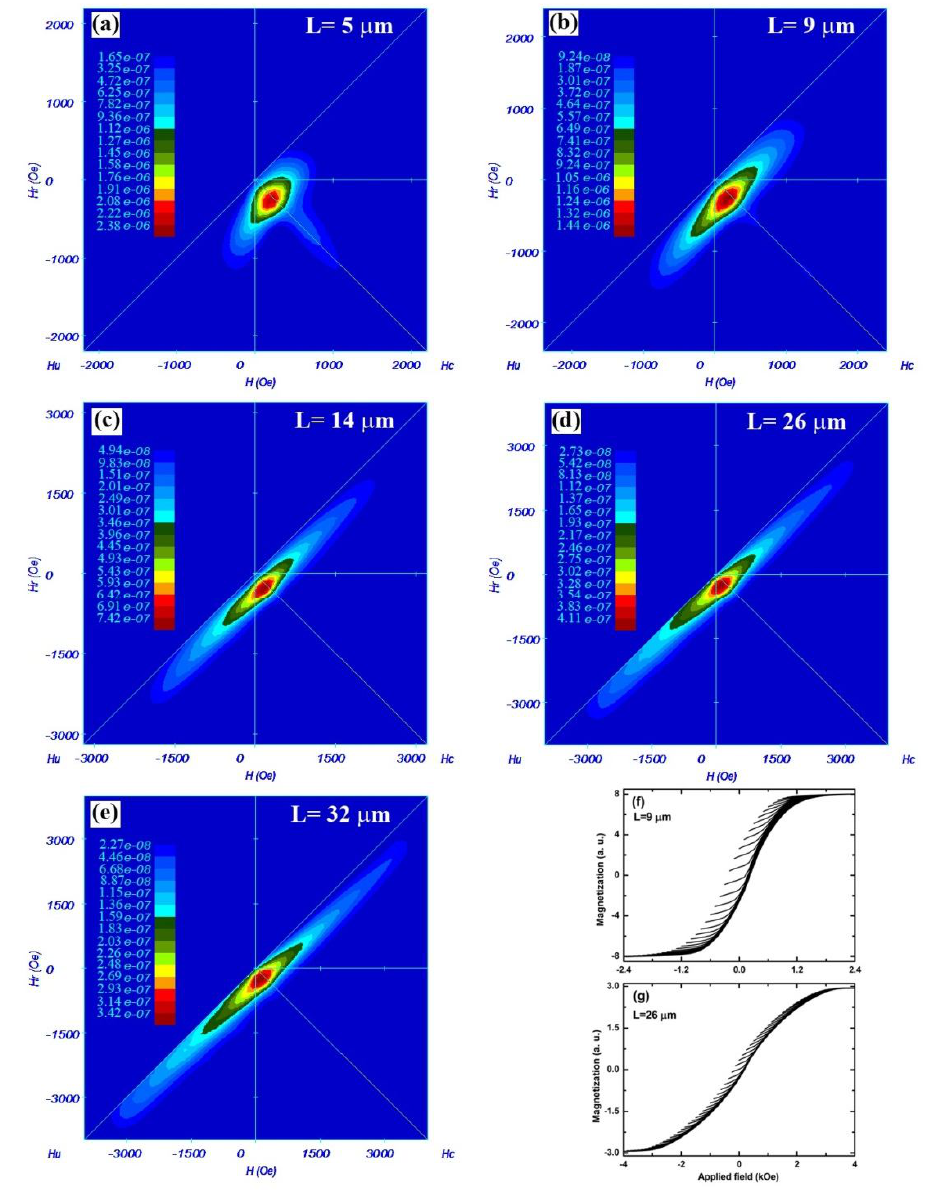
Fig. 5. (a) Out-of-plane hysteresis loops of samples with various nanowire lengths. The length dependence of saturation magnetic moment is inserted. (b) Coercivity and squareness as a function of NWs